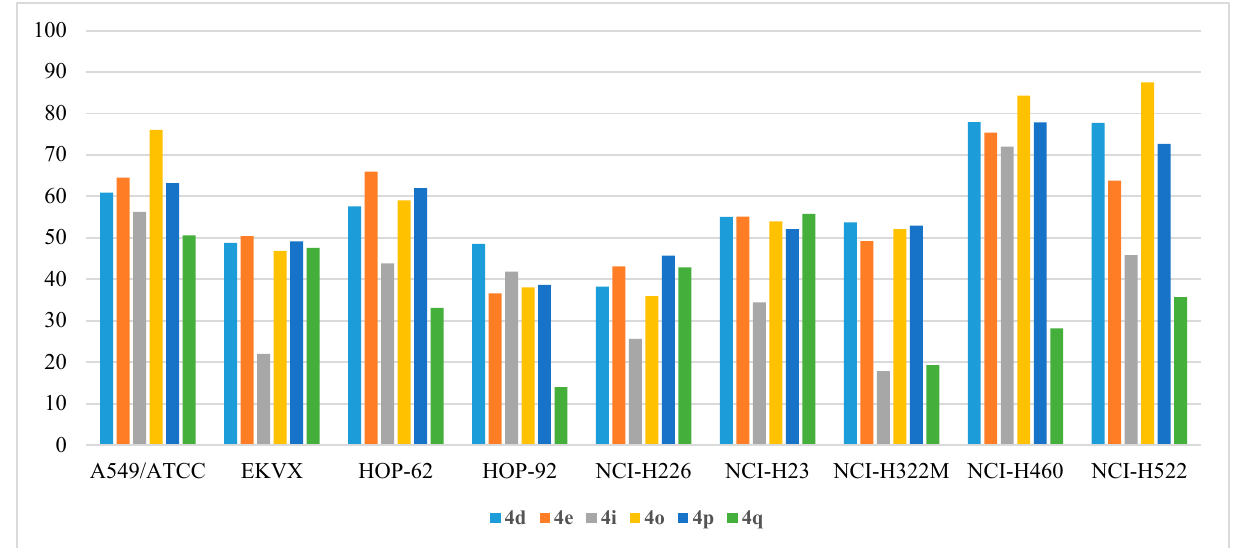
Figure 6. Anti-proliferative activities (% GI) of compounds 4d , 4e , 4i , 4o , 4p , and 4q against NSCLCs. (cid:4) Anti-proliferative activity on colon cancers: